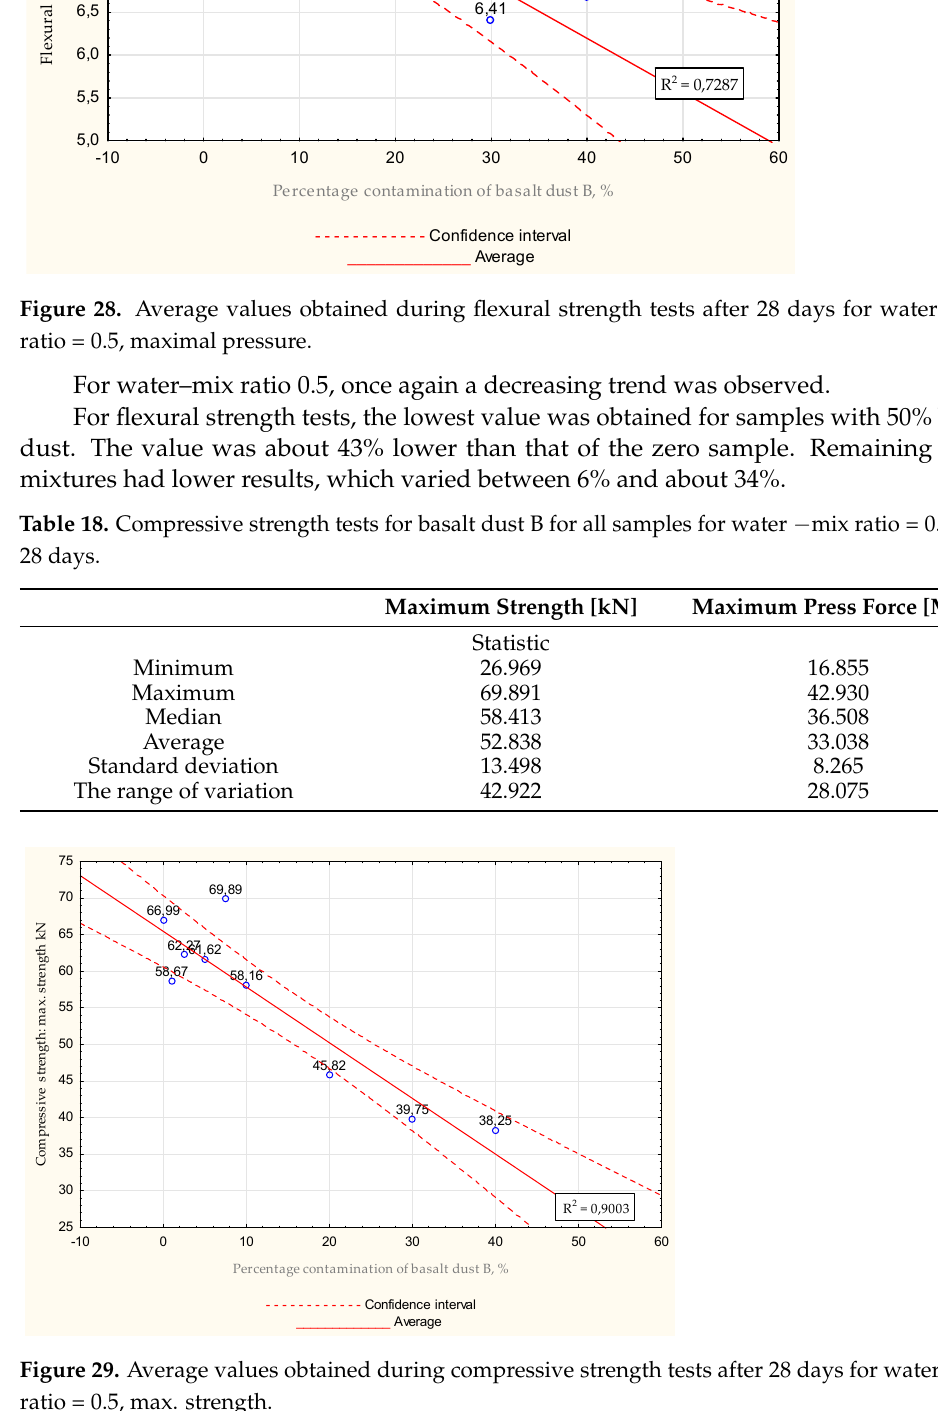
R 2 = 0,9056 Figure 30. Average values obtained during compressive strength tests after 28 days for water − mix ratio = 0.5, max. pressure. Almost all results obtained from compressive strength tests were lower than those of the zero sample. The lowest value was obtained for contamination of basalt dust of 50%, which decreased its strength by about 60%. For remaining results the difference varied between 7% and 42%.